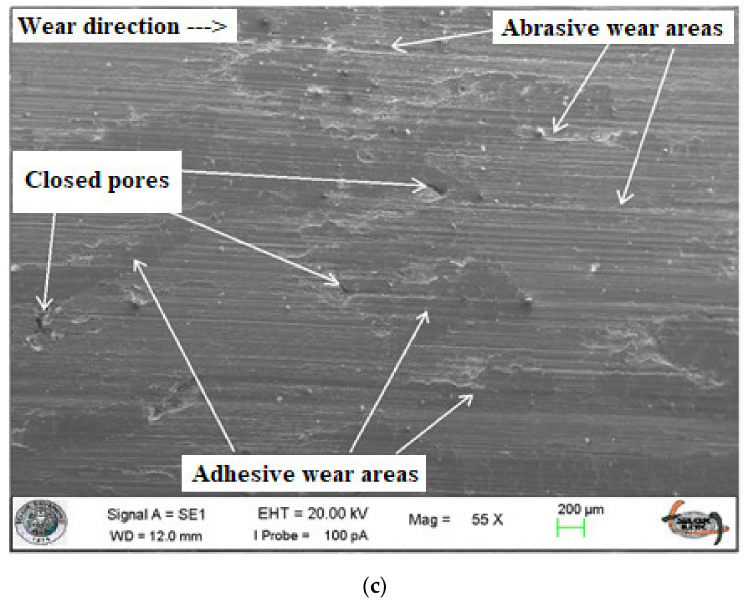
Figure 4. SEM image of 70B30C: ( a ) before wear, ( b ) after wear, and ( c ) SEM image of 60B40C after